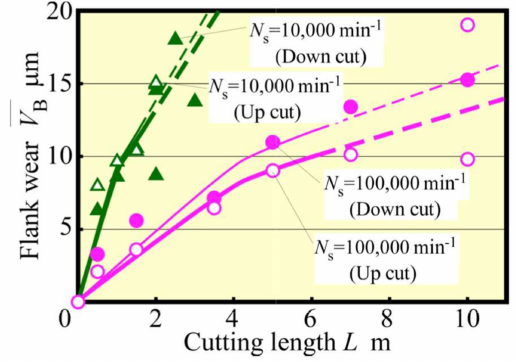
Figure 3. Change of flank wear with cutting length ( f = 5 µ m / tooth).